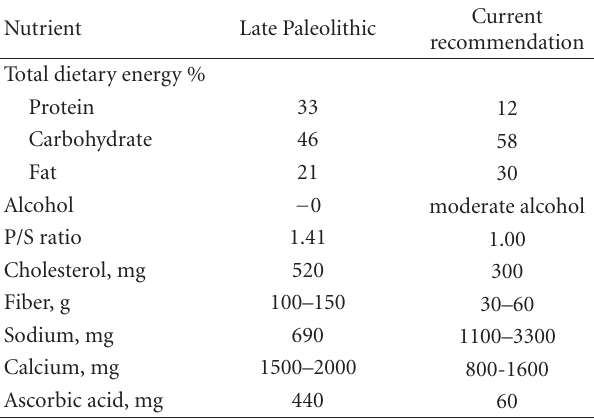
Table 3: Nutrient composition in the late Paleolithic and current recommendations.